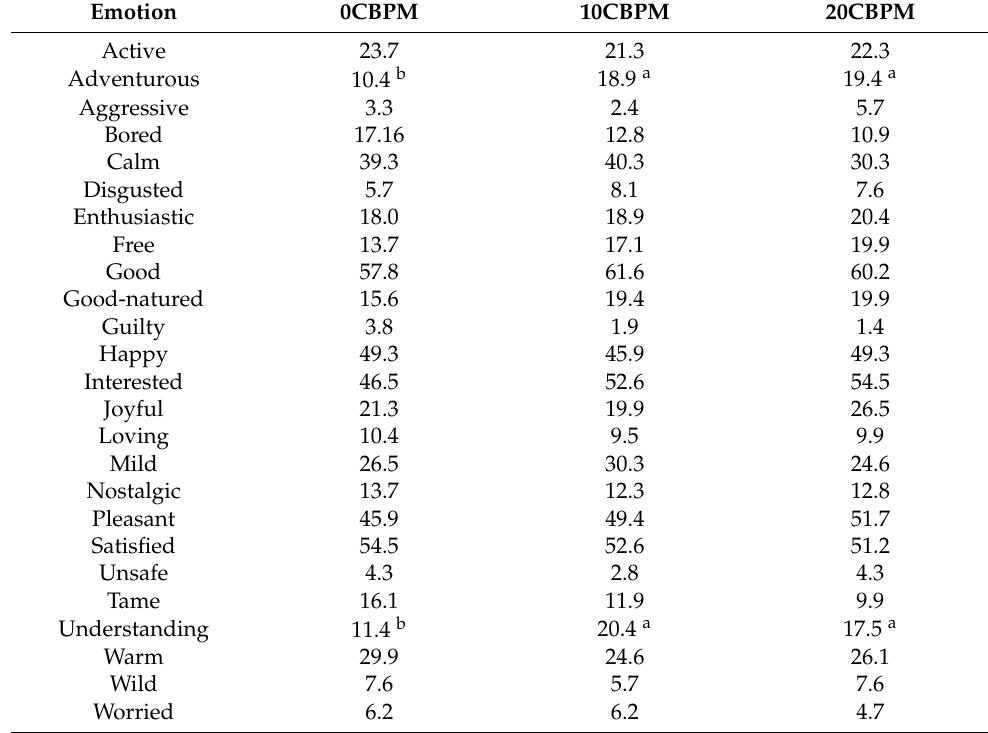
Table 4. Consumer emotional responses (%) 1 elicited by fried catfish strips 2